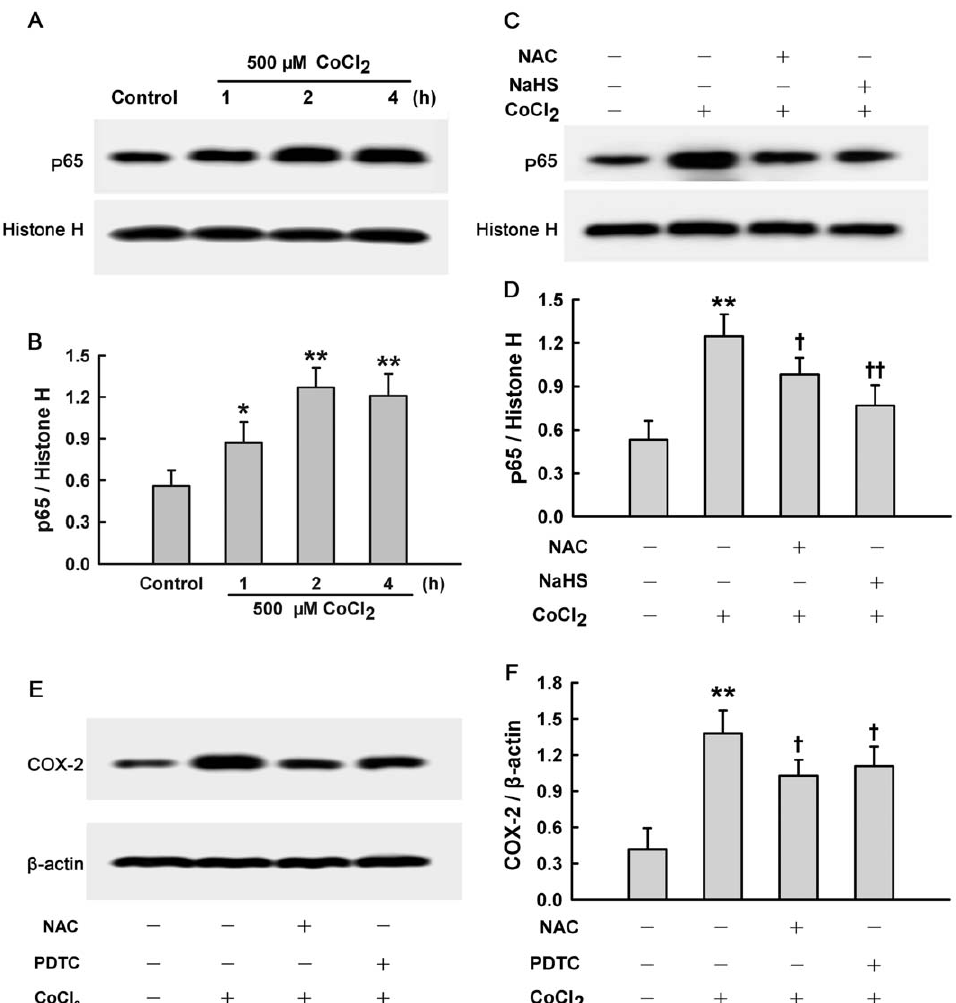
Figure 6. Effects of different treatments on CoCl 2 -induced intranuclear accumulation of NF- k B p65 subunit and overexpression of COX-2 in HaCaT cells. ( A ) HaCaT cells were treated with 500 m M CoCl 2 for the indicated times. ( C ) HaCaT cells were pretreated with 400 m M NaHS for 30 min or 1000 m M NAC for 60 min followed by treatment with 500 m M CoCl 2 for 2 h. Nuclear extract lysates were subjected to Western blot analysis using p65-specific antibody. ( E ) HaCaT cells were treated with 500 m M CoCl 2 for 6 h in the absence or presence of pretreatment with 1000 m M NAC for 60 min or 10 m M PDTC for 30 min. Cell lysates were subjected to Western blot analysis using COX-2-specific antibody. Panels B , D and F show the intensity of the protein bands of typical experiments from A, C and E, respectively. Data were shown as the mean 6 SE. * P , 0.05, ** P , 0.01 compared with control group. + P , 0.05, ++ P , 0.01 compared with CoCl 2 treatment group.